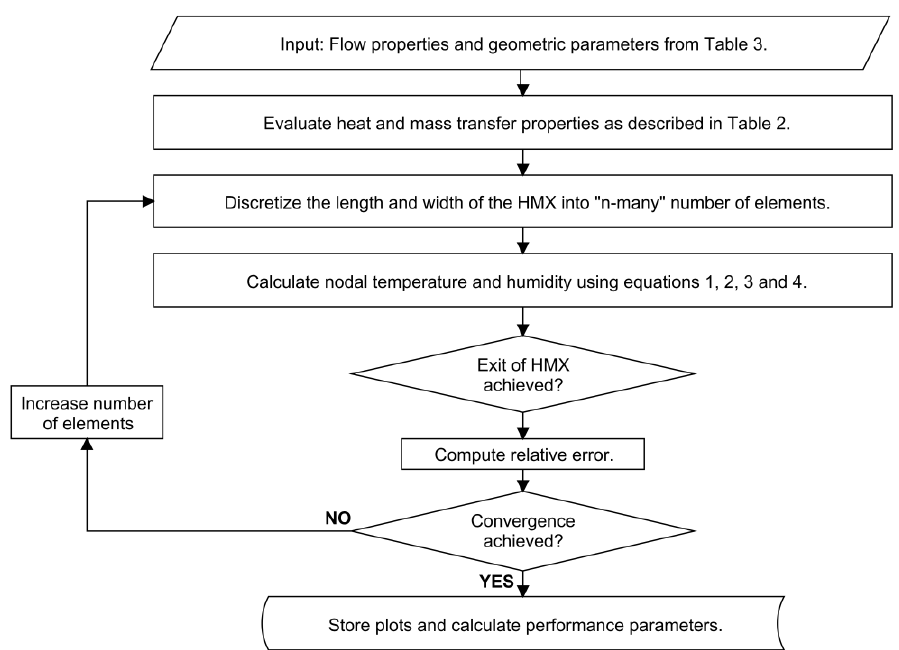
Figure 3. Methodology diagram of the numerical